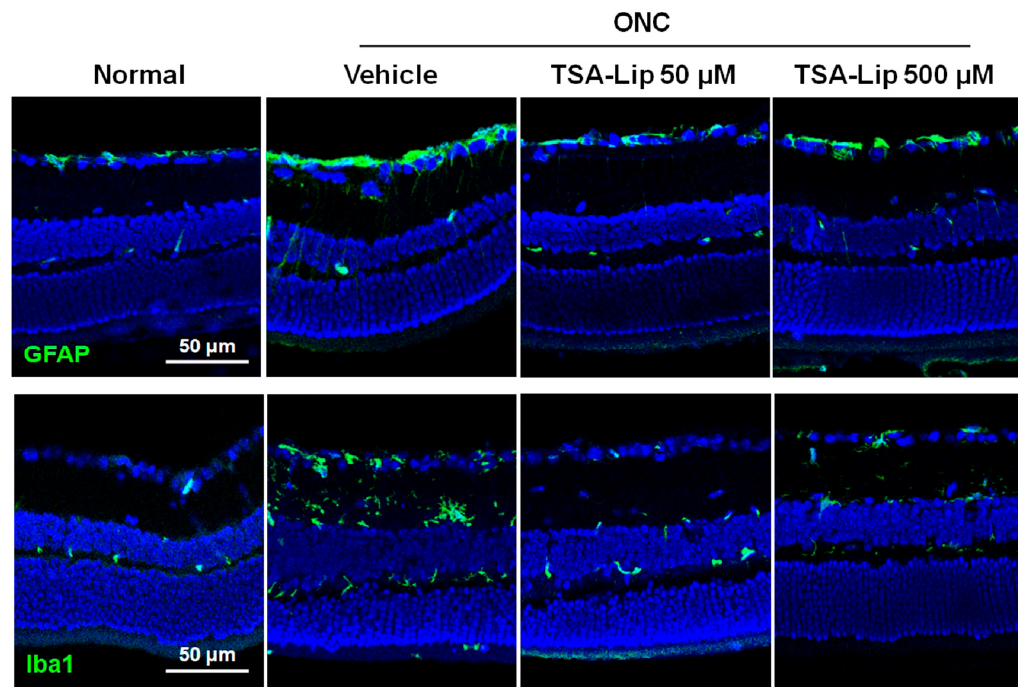
Figure 6. Immunohistochemical staining of GFAP and Iba1 in retinas at 7 days after ONC. (Upper) Sections from vehicle-injected retinas after ONC show increased GFAP activity on the RGC layer and the radial process of macroglial cells spanning the inner plexiform layer. The intravitreal injection of TSA-loaded liposomes significantly attenuated the GFAP activity in retinas after ONC. (Lower) Immunolabeling for Iba1 in retinal sections showed prominent activation of microglia in vehicle-injected retinas after ONC. This activation was ameliorated in the retinas injected with TSA-loaded liposomes. Images with lower magnification are presented in Supplementary Figure S2. TSA - Lip 50 µ M = liposomes loaded with 50 µ M TSA; TSA - Lip 500 µ M = liposomes loaded with 500 µ M